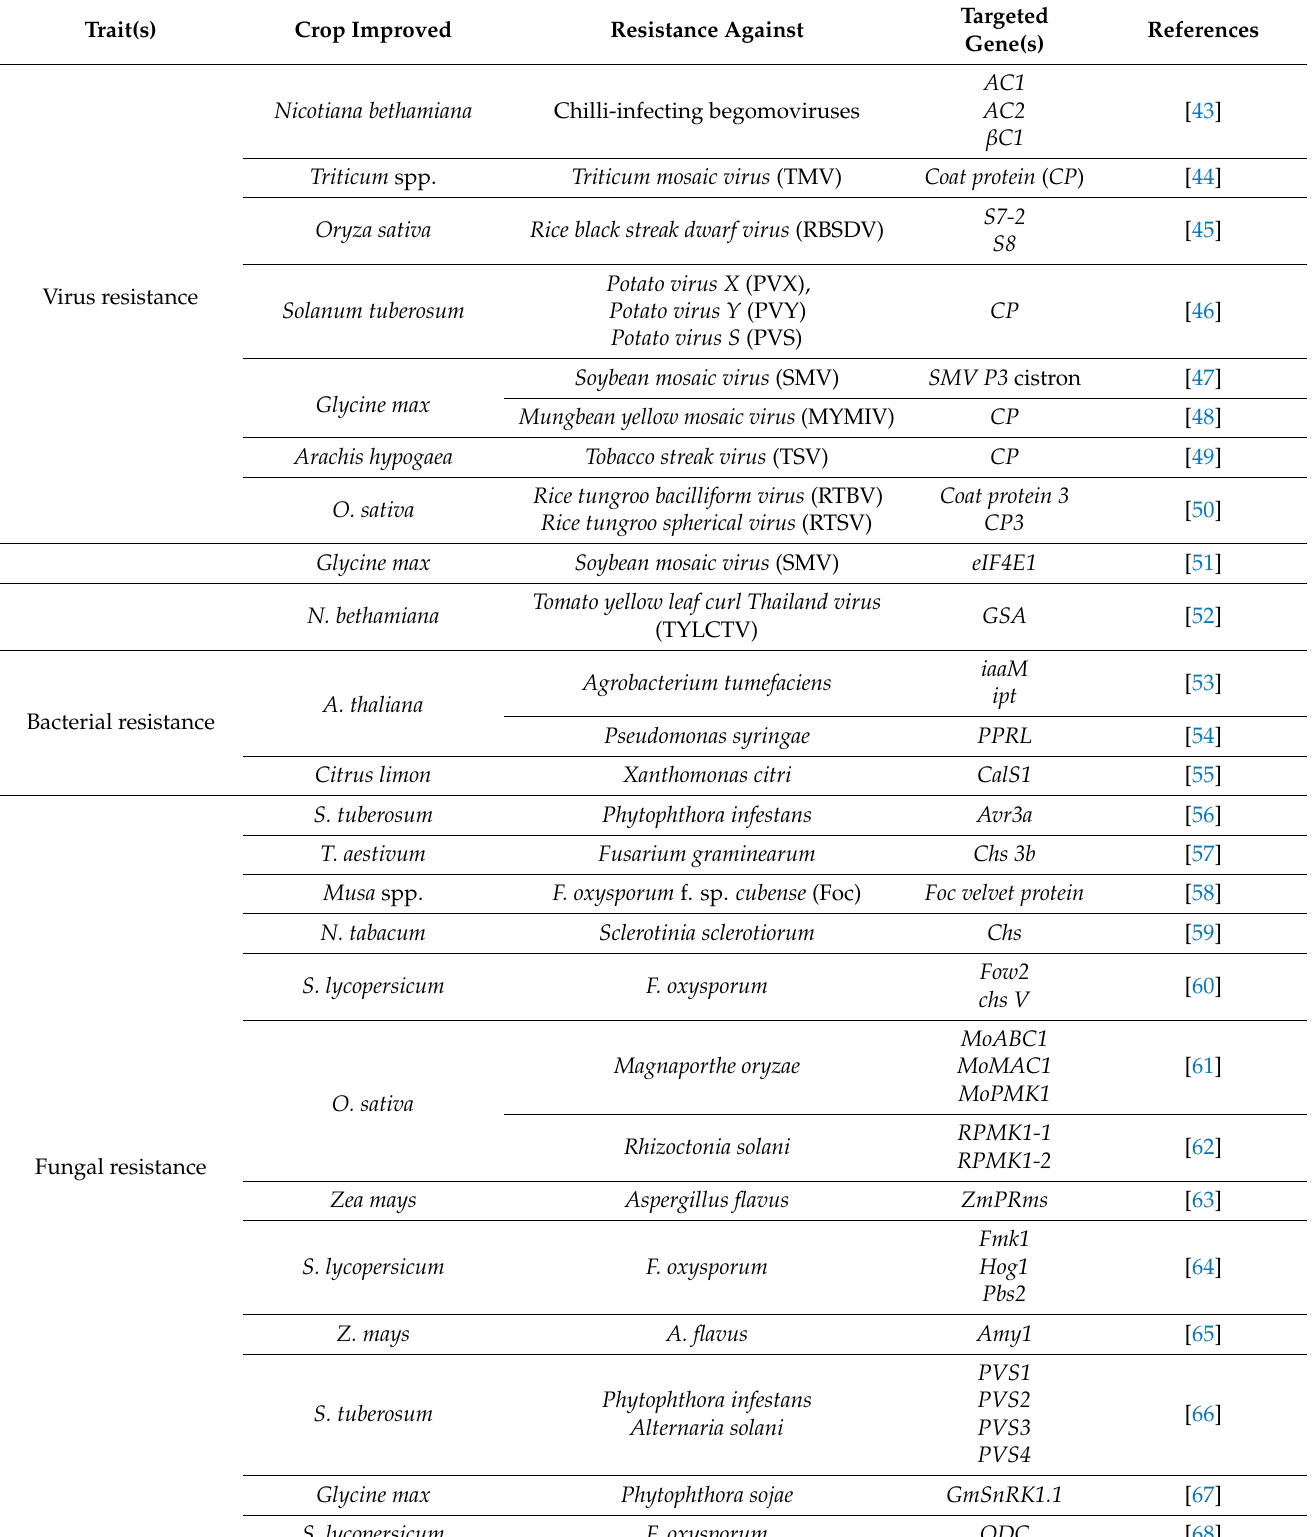
Table 1. Crops with improved stress tolerance through